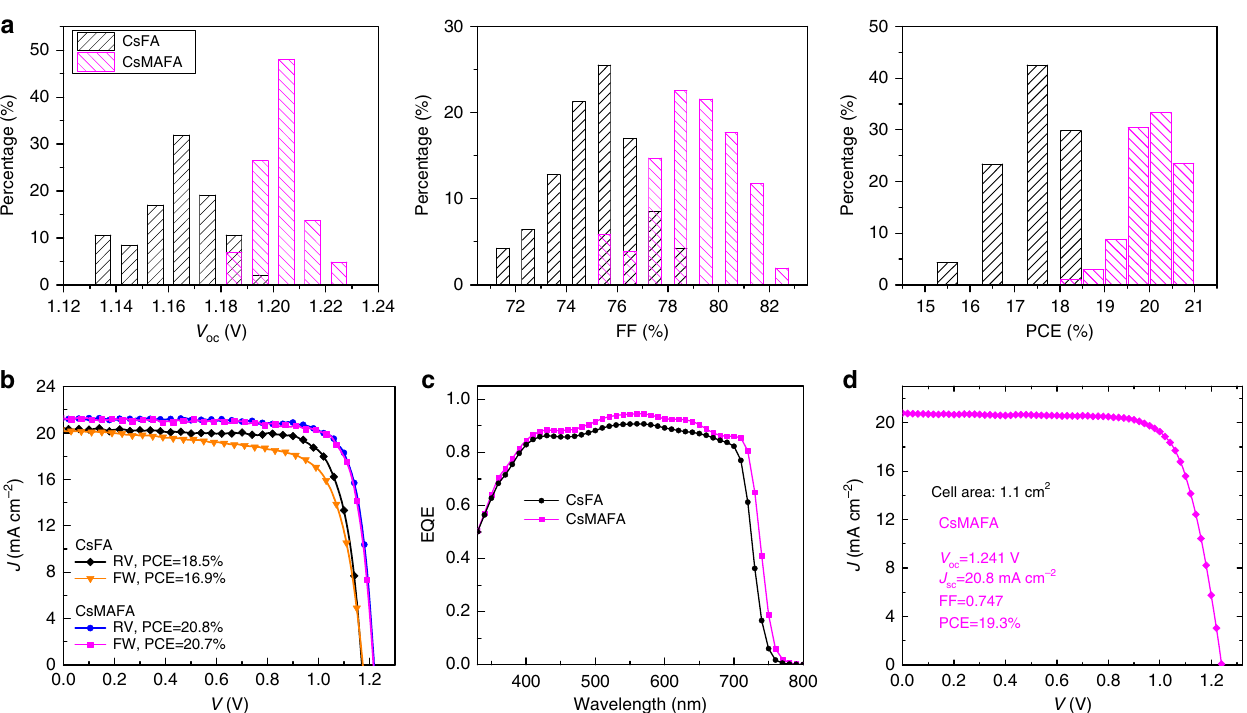
Fig. 2 Photovoltaic performance of wide-bandgap perovskite solar cells. a Histograms of V oc , FF, and PCE of 47 CsFA solar cells and 102 CsMAFA devices. b Reverse (RV) and forward (FW) J – V curves of best-performing CsFA and CsMAFA perovskite solar cells. c EQE curves of CsFA and CsMAFA perovskite solar cells, corresponding to integrated J sc values of 19.4 and 20.7 mA cm − 2 , respectively. d J – V curve of best-performing CsMAFA solar cell with an active area of 1.1 cm 2 . CsFA and CsMAFA stand for the compositions of Cs 0.2 FA 0.8 Pb(I 0.75 Br 0.25 ) 3 and Cs 0.05 MA 0.15 FA 0.8 Pb(I 0.75 Br 0.25 ) 3 ,